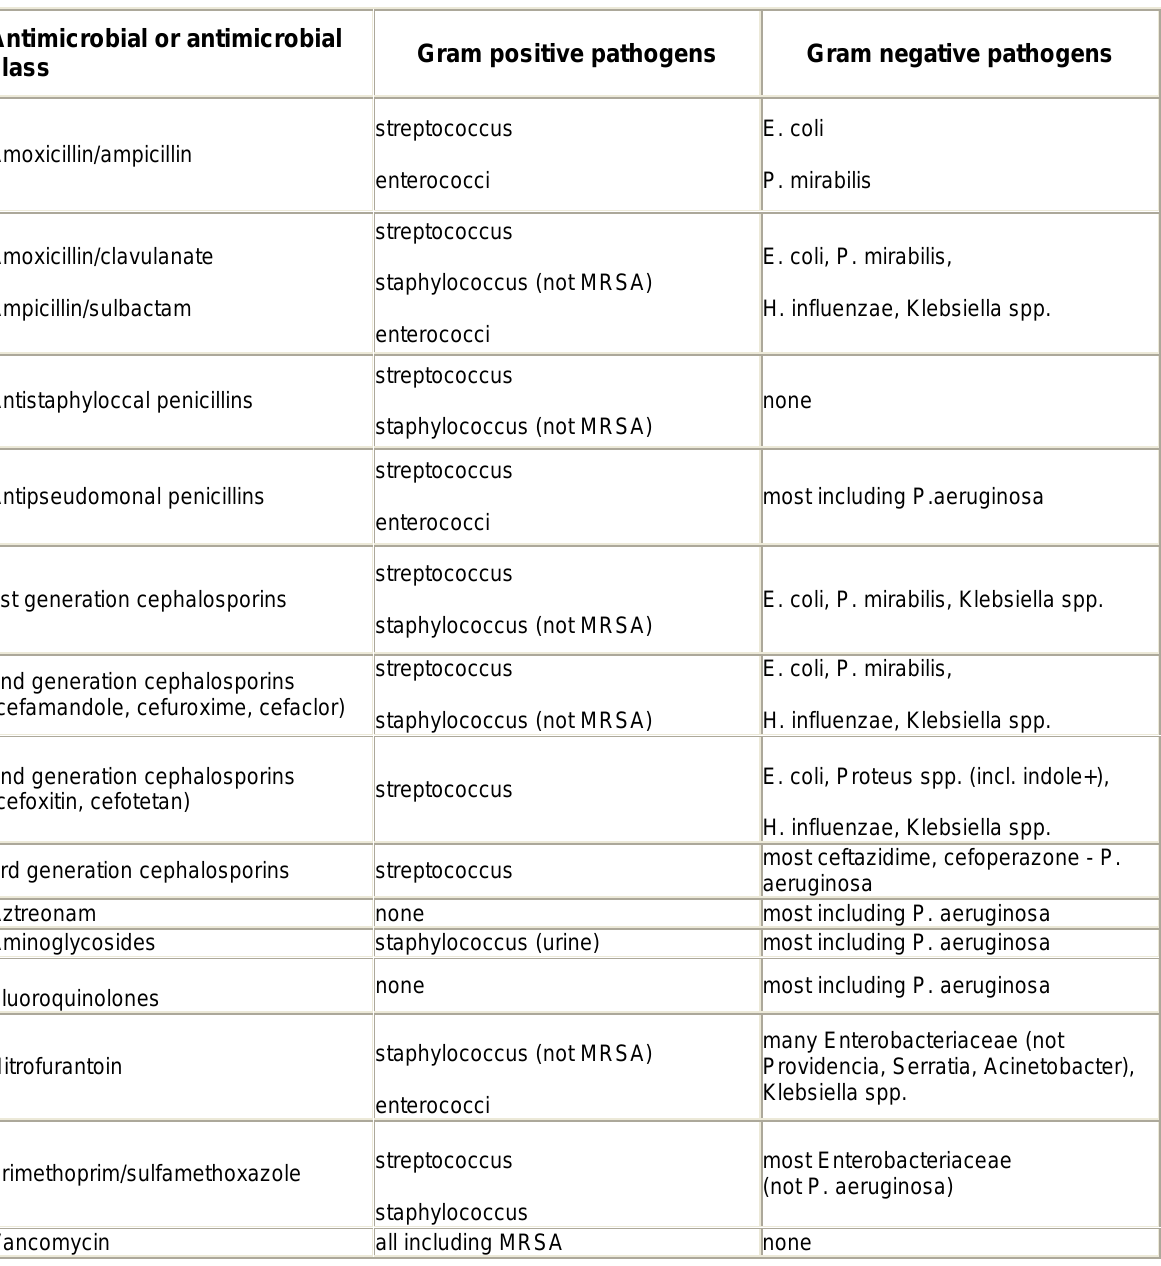
Reliable Coverage of Antimicrobials Used in the Treatment of Urinary Tract Infections of Commonly Encountered